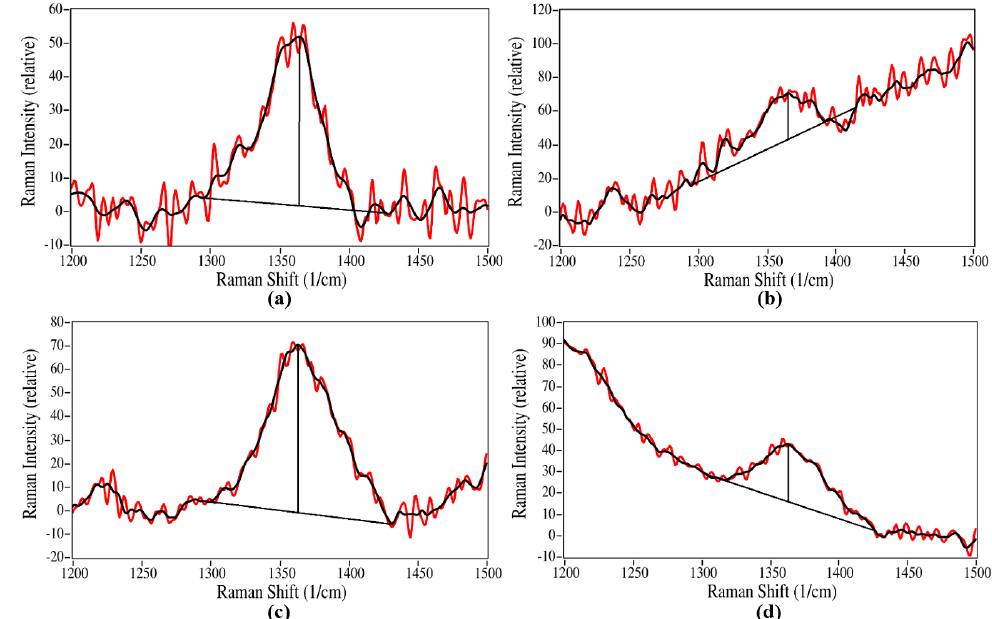
Figure 2. Raman raw (red) and smoothed (black) spectra of 2650 ppm sulfate in HPLC water plus ( a ) 100 and ( b ) 30 ppm HCO 3 − from Series 1, and ( c ) 125 and ( d ) 50 ppm HCO 3 − from Series 2, illustrating baseline correction and simple peak height determination (see Figures S2 and S3). Conditions: 1.5 W at 532 nm, Series 1: two 240 2-Sec integration scans averaged (16 min), Series 2: eight 240 2-Sec integration scans averaged (64 min).